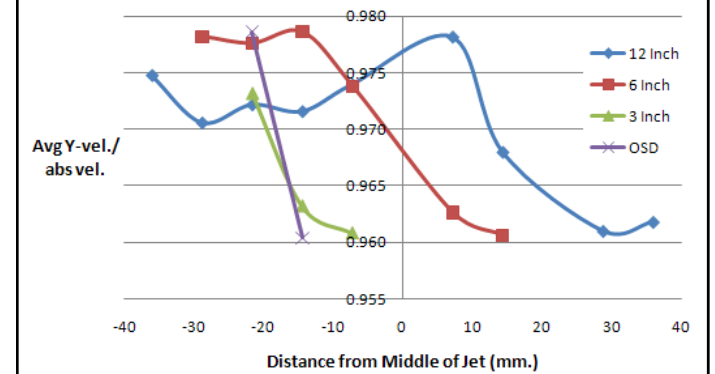
Figure 10. %Y-velocity distribution along the jet width in large standoff